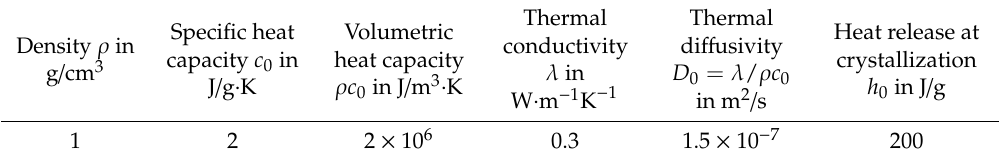
Table 1. Typical thermal parameters of a polymer matrix (at room temperature and normal pressure).